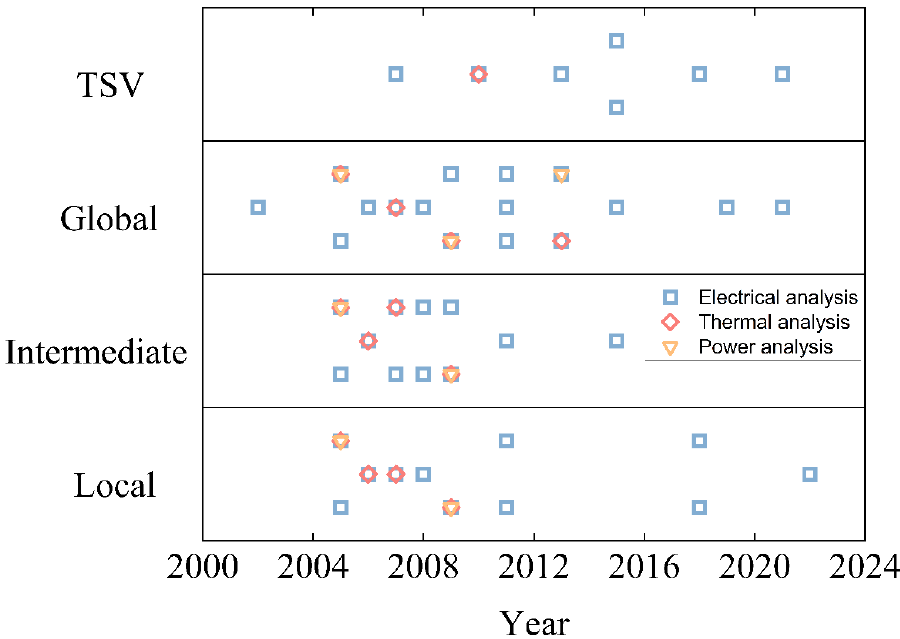
Figure 3. A timetable summarizing recent developments in CNT-based interconnects on local, intermediate, global, and TSV stages with their corresponding electrical, thermal, and power analysis. For TSV level, square patterns represent the related references [27,32–37], from left to right respectively. Rhombus patterns represent the related reference [32]. For global level, square patterns represent the related references [20–24,38–48], from left to right respectively. Rhombus patterns represent the related references [23,24,45,49], from left to right respectively. Triangle patterns represent the related references [23,24,44], from left to right respectively. For intermediate level, square patterns represent the related references [21–24,38–40,42,46,50,51], from left to right respectively. Rhombus patterns represent the related references [23,24,39,52], from left to right respectively. Triangle patterns represent the related references [23,24] from left to right respectively. For local level, square patterns represent the related references [21–24,38,39,41,53–56], from left to right respectively. Rhombus patterns represent the related references [23,24,39,52], from left to right respectively. Triangle patterns represent the related references [23,24], from left to right